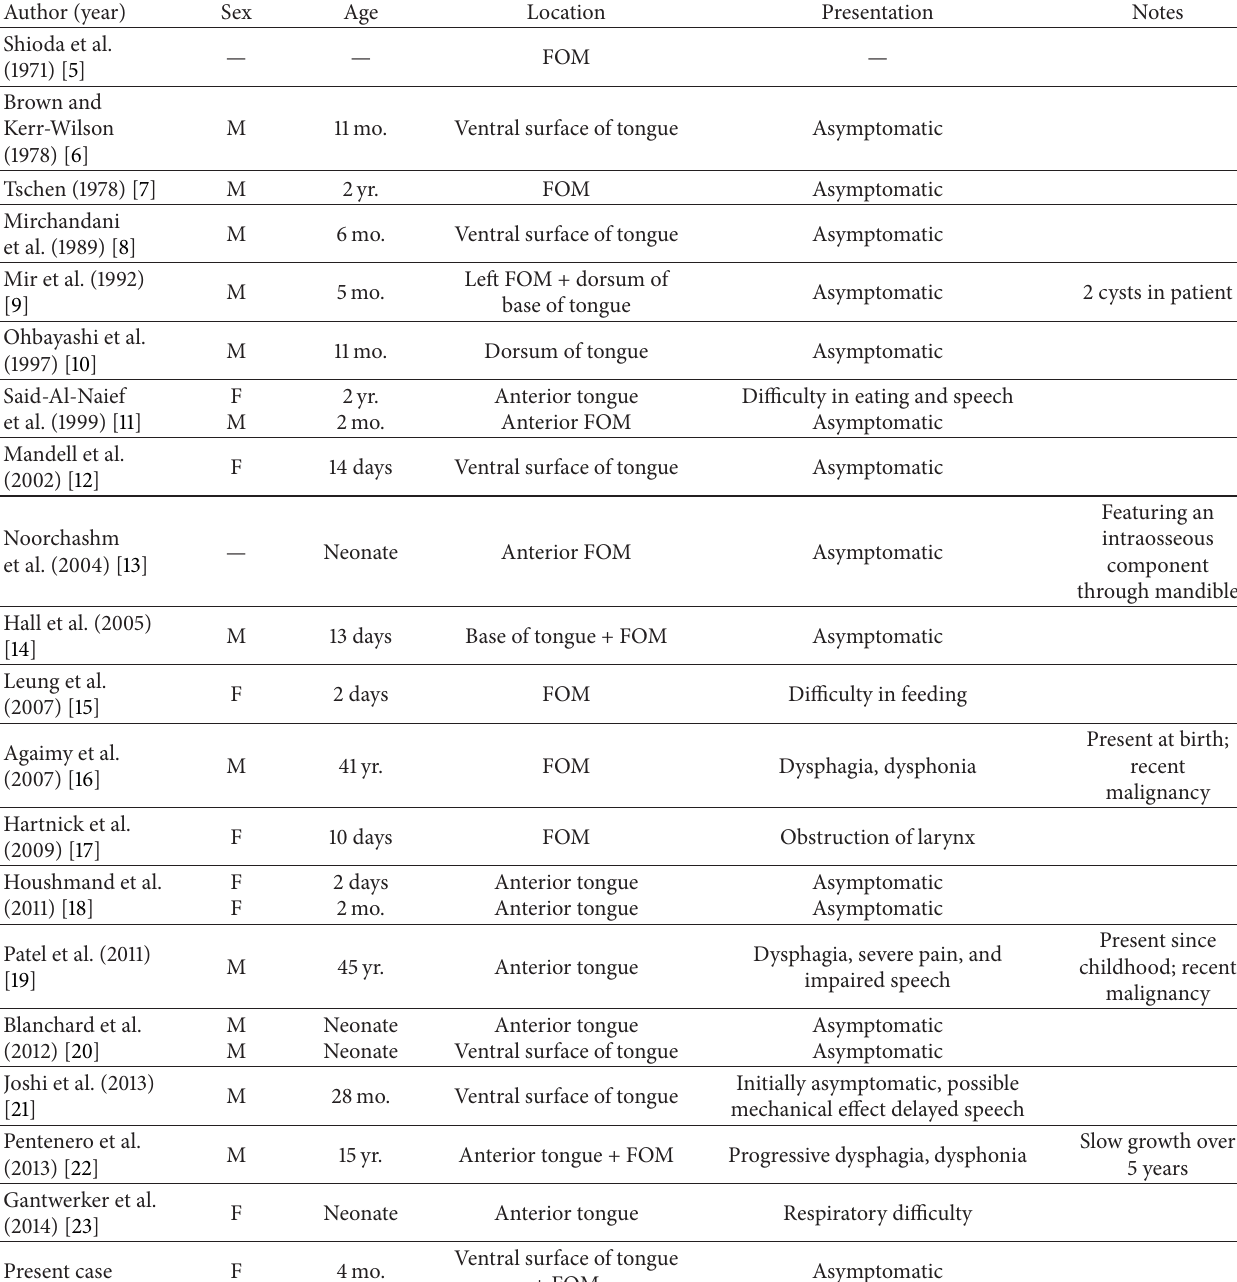
Table 1: Reported cases of intraoral cysts involving gastric and respiratory